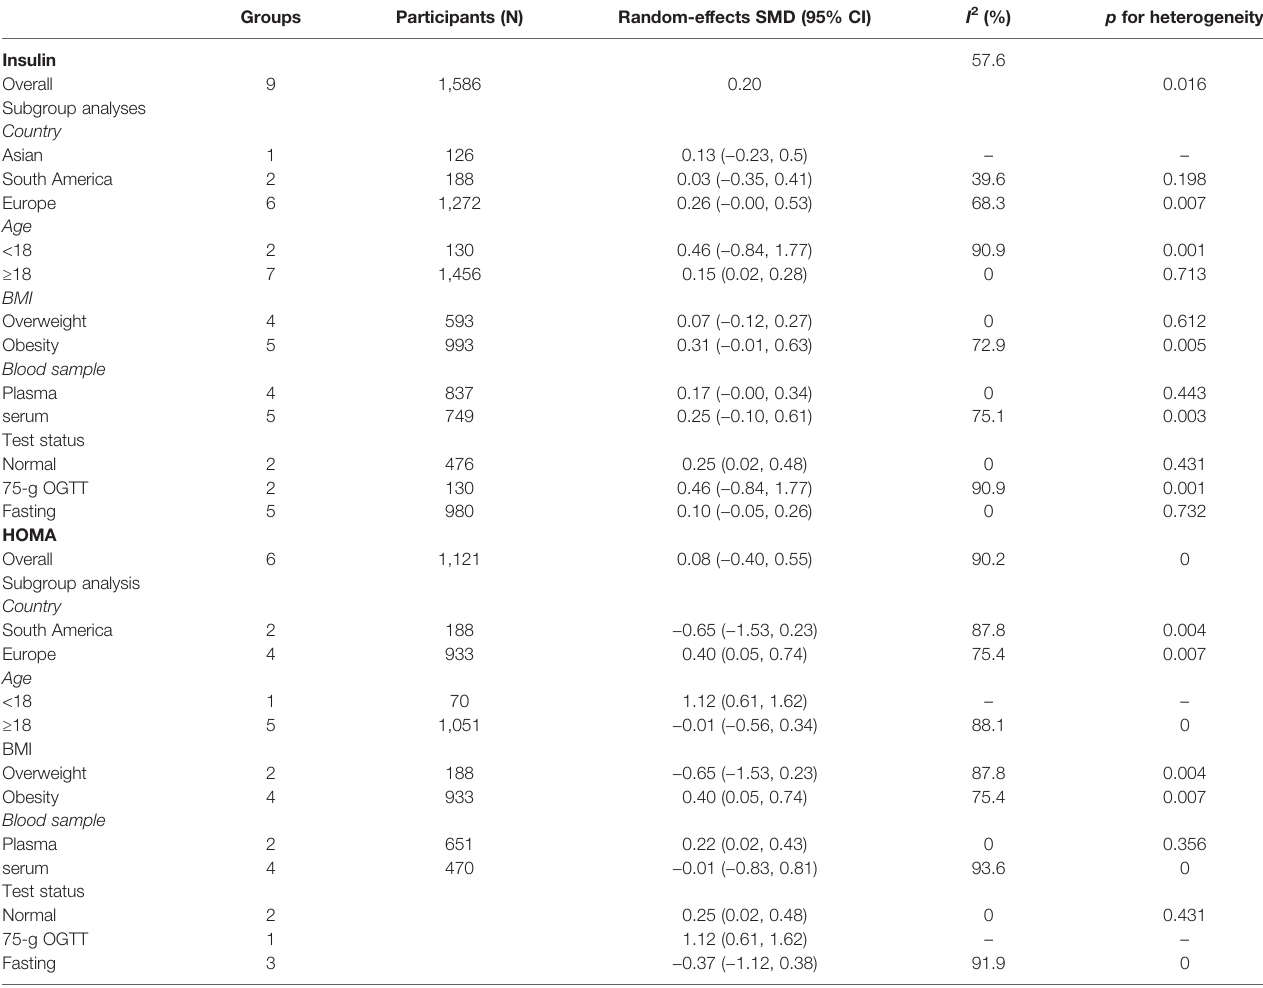
TABLE 2 | Subgroups analyses of relationship between Trp64Arg mutation and insulin